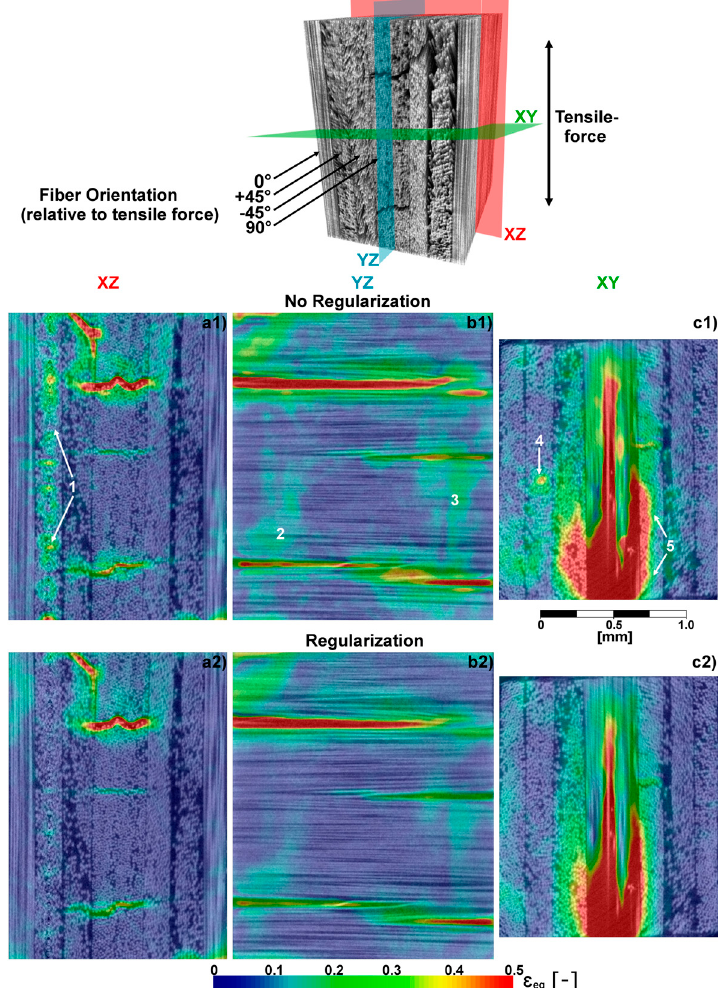
Figure 6. Top: Volume rendering with fiber orientation and force indicator. The coordinate system is adopted from Figure 4. Colored planes represent the positions of the 2D images shown in ( a1 – c2 ); ( a1 – c2 ) contain von-Mises equivalent strain quantities superimposed on the respective CT-slices. Landmarks (1–5) in ( a1 – c1 ) emphasize locations of ambivalent and erroneous strain quantities distinctly reduced by the implementation of the regularization (see ( a2 – c2 )).